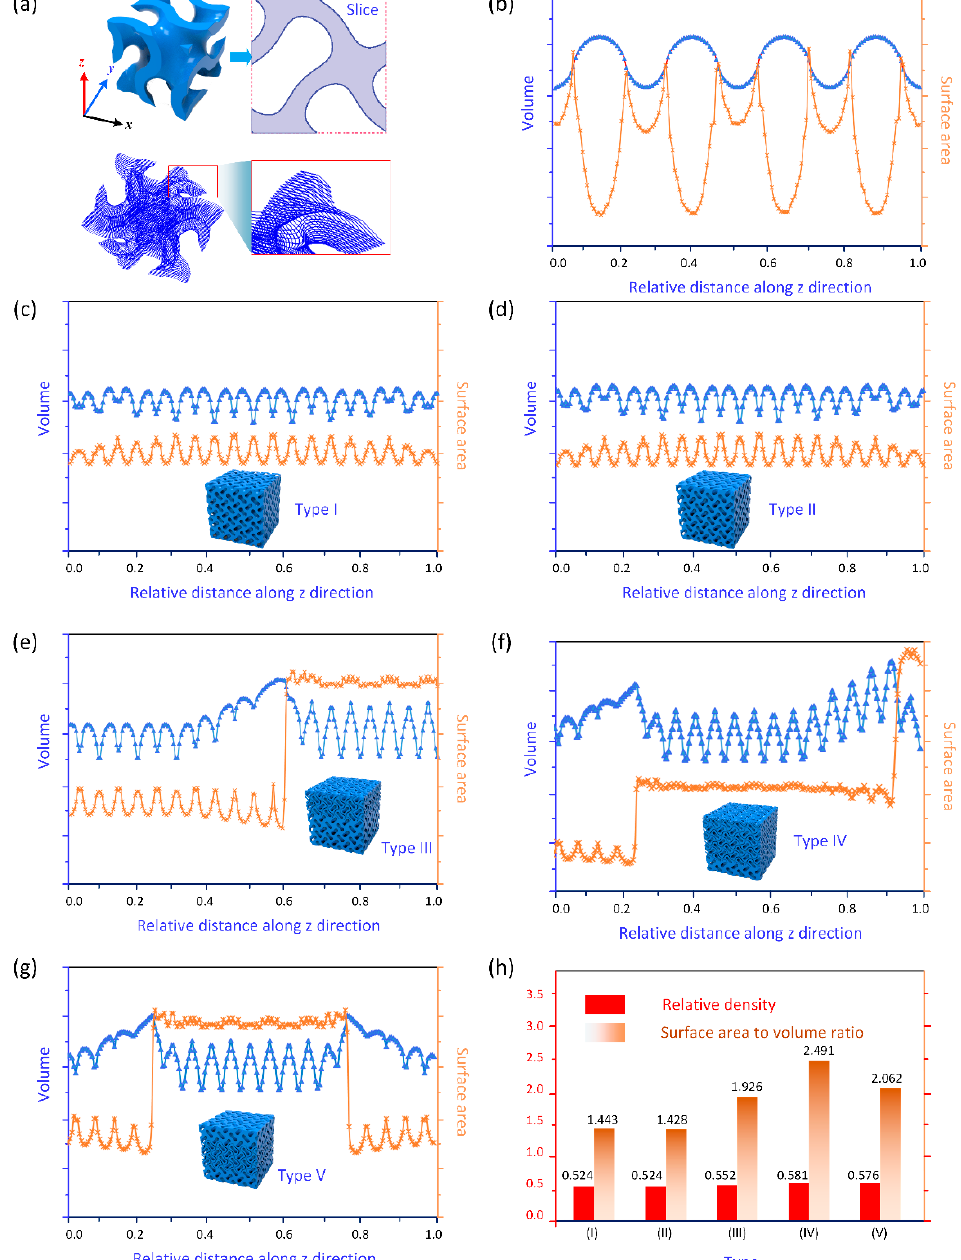
Figure 5. ( a , b ) Illustration of the slice-based method for evaluation of RD and surface area with a Gyroid sheet unit cell; ( c – g ) RD and surface area of Types I–V using slice-based method; and ( h ) RD and surface area based on digital models.